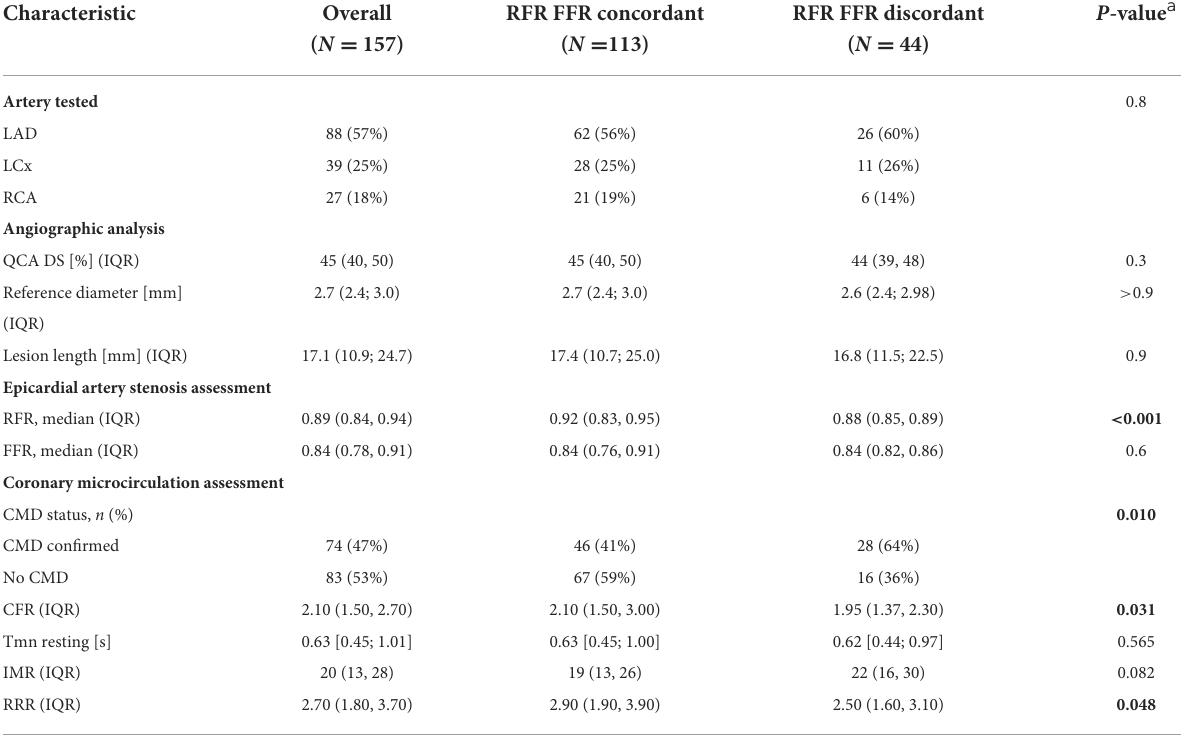
TABLE 2 Angiographic and functional characteristics of analyzed